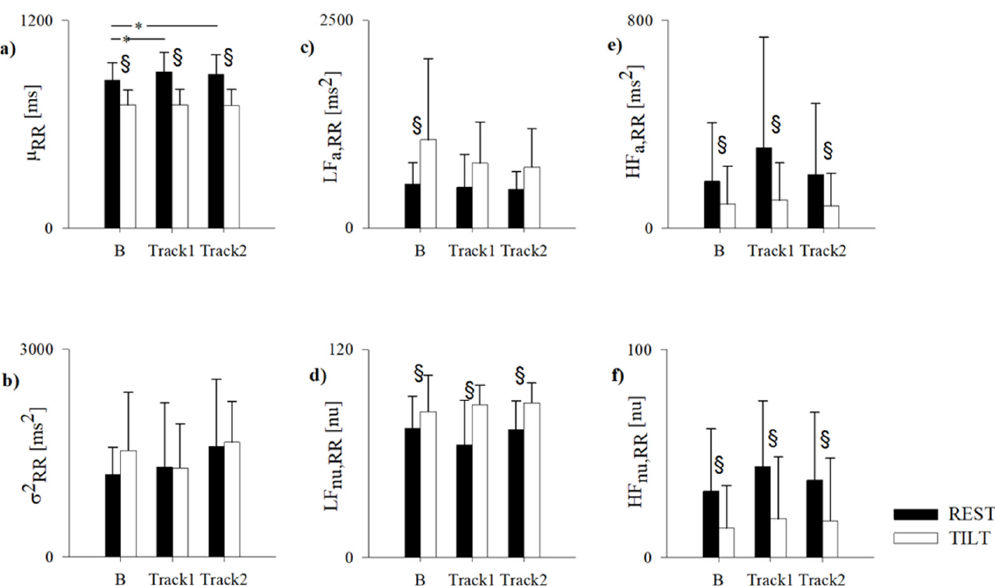
Figure 3. Results of the RR variability analysis in the healthy subjects while supine (REST) and during 70 ◦ head-up tilt test (TILT) in normal condition (B) and while listening activating (Track1) and relaxing (Track2) algorithmic music. RR, RR interval; µ RR , RR mean ( a ); σ 2 RR , RR variance ( b ); LF, low frequency; LF a,RR , absolute power of RR in the LF band ( c ); LF nu,RR , normalized power of RR in the LF band ( d ); HF, high frequency; HF a,RR , absolute power of RR in the HF band ( e ); HF nu,RR , normalized power of RR in the HF band ( f ). Data are expressed as mean ± standard deviation. § indicates p < 0.05 REST vs. TILT. * Indicates B vs. Track1 and vs. Track2.